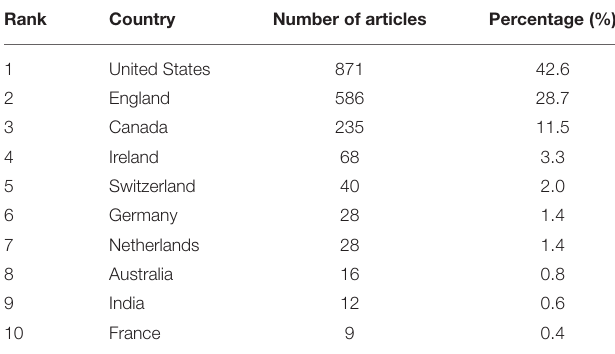
TABLE 1 | Statistics on the number of studies on online health information-seeking behavior by country (top